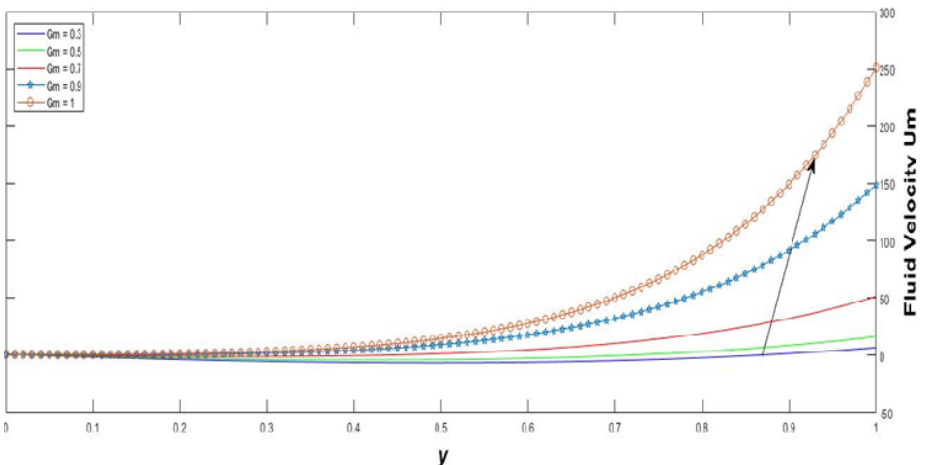
Figure 4. Velocity field for various Young Modulus